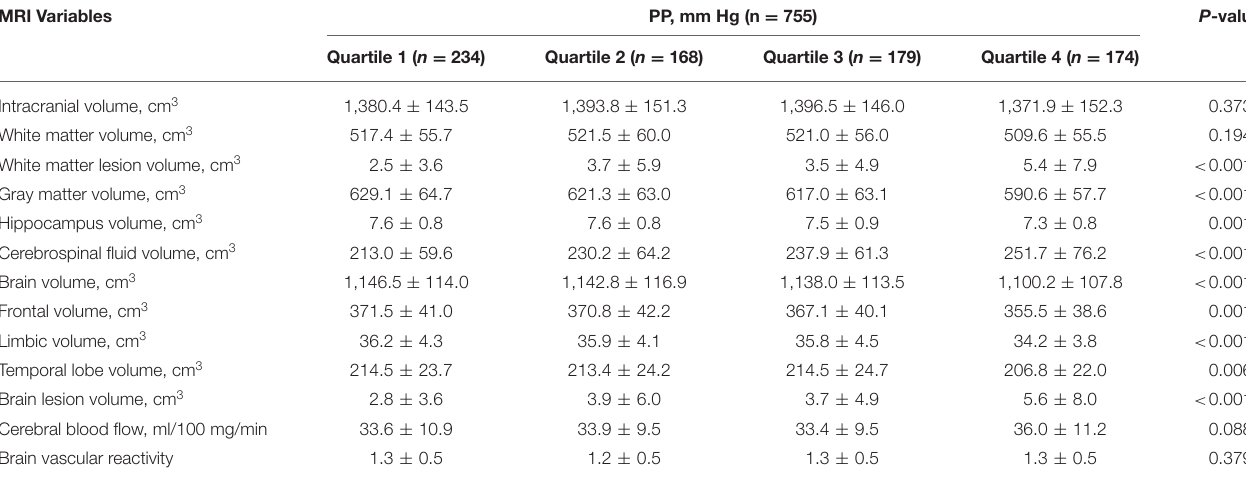
TABLE 4 | Performance on brain magnetic resonance imaging (MRI) variables by PP quartile in SPRINT-MRI subgroup.